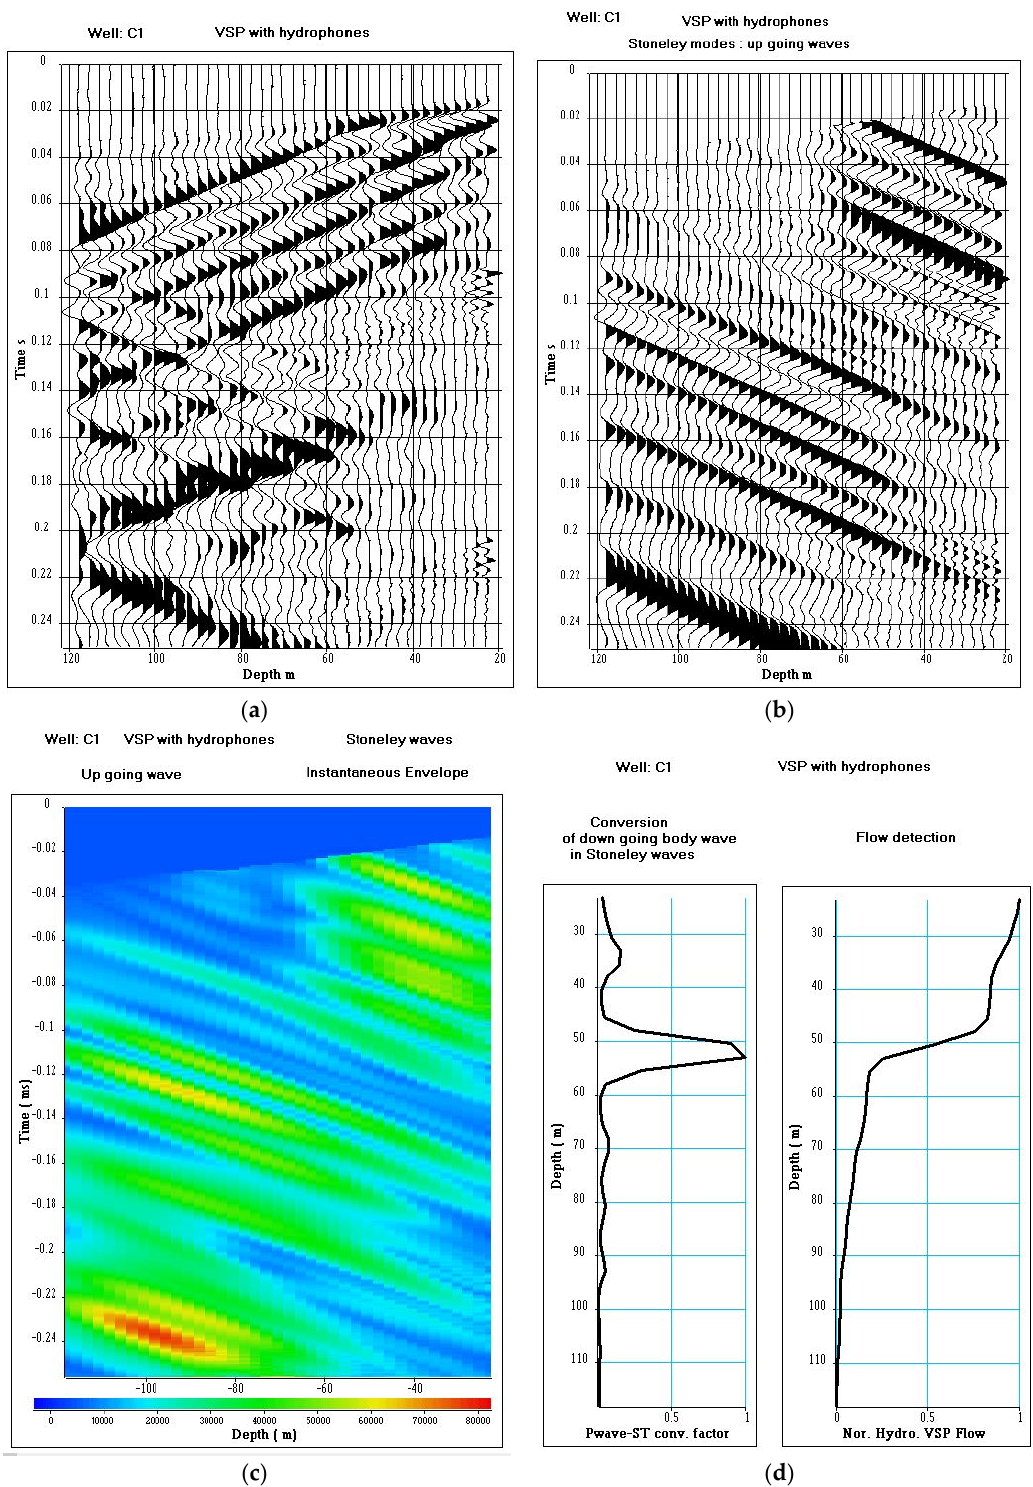
Figure 12. VSP processing. ( a ) VSP after amplitude recovery, ( b ) upward propagating Stoneley wave, ( c ) amplitude of upward propagating Stoneley wave, ( d ) P-wave / Stoneley-wave conversion factor and Normalized VSP flow.